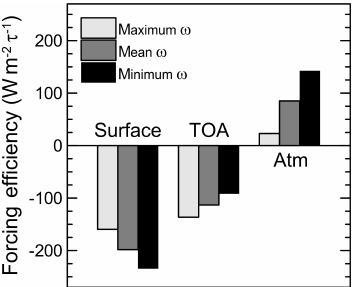
Figure 10. Aerosol shortwave forcing efficiency at 60 ◦ solar zenith angle calculated at the surface, TOA, and within the atmosphere for the maximum, mean, and minimum of the single scattering albedo ( ω) observed in this study (Table